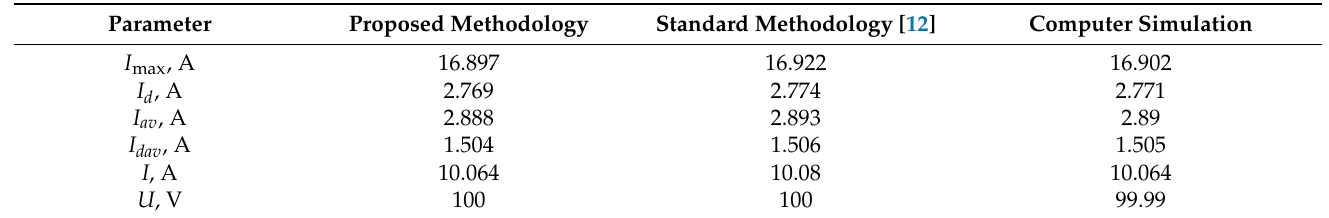
Table 1. Values of quantities obtained from the design of a voltage source inverter and the results of computer